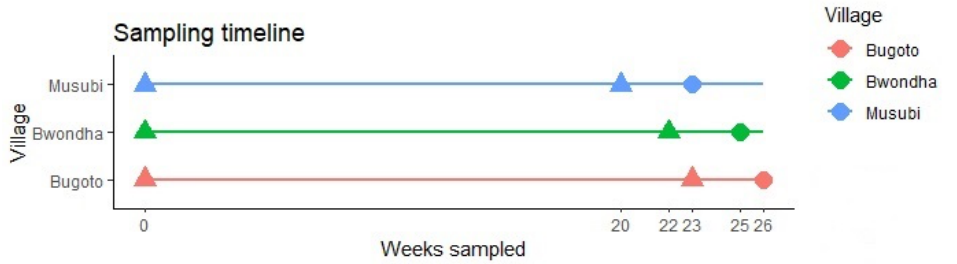
Figure 1. Kato–Katz thick smear sampling (three days of duplicate Kato–Katz at each time point) and praziquantel treatment timeline, indicating the weeks sampling occurred in each school. Triangles indicate praziquantel administration given, after stool samples were collected, on that week, and circles denote treatment was only administered to children with Schistosoma mansoni detected infections.